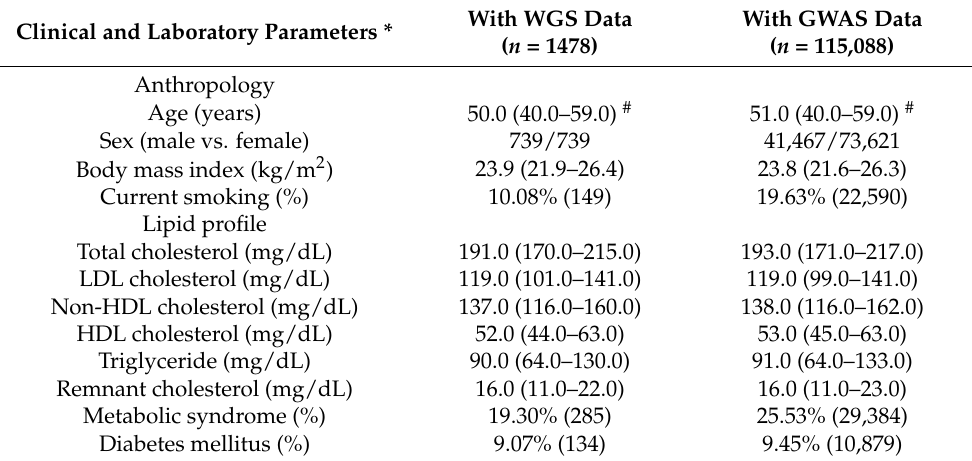
Figure 1. Flowchart of inclusion and exclusion criteria used to screen Taiwan Biobank project participants. Table 1. Baseline characteristics of Taiwan Biobank participants .